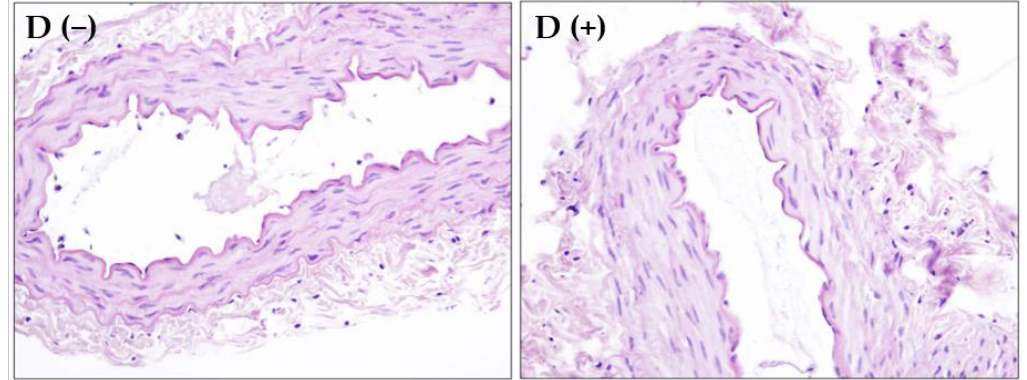
Figure 1. Rat femoral artery vascular rings with endothelium isolated from healthy (D − ) and diabetic (D +) animals after hematoxylin and eosin staining (magnification 400×).